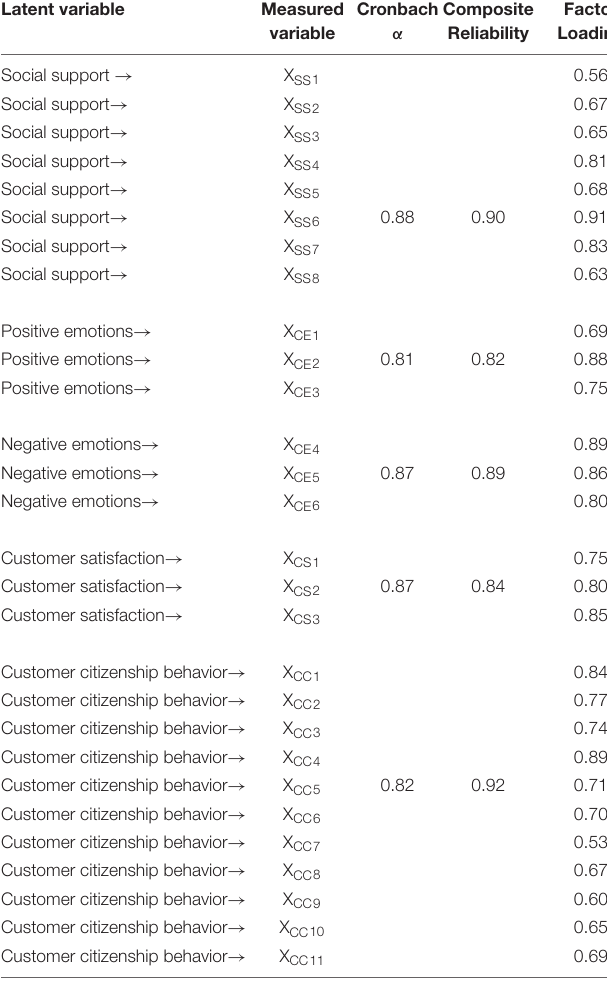
TABLE 3 | Differential validity test of latent